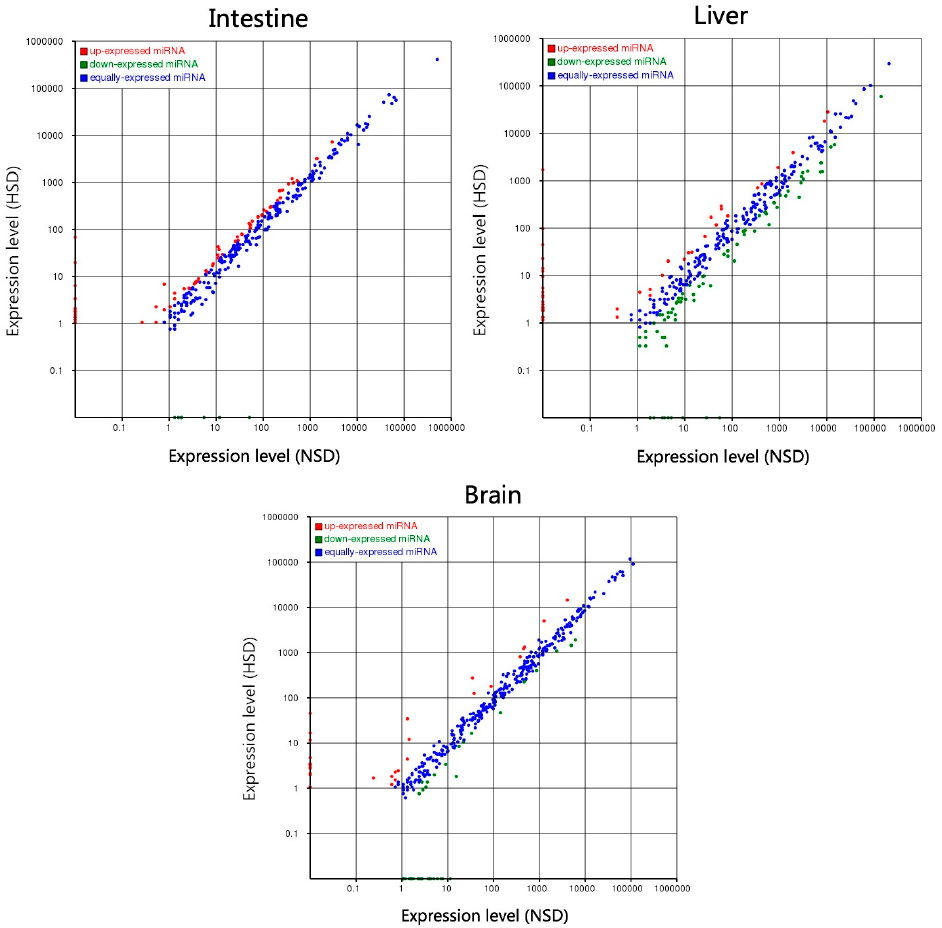
Figure 2. Differentially expressed miRNAs M. amblycephala. Red and green represents up- and downregulated miRNAs in high starch diet (HSD) group, compared with low starch diet (NSD) group. |log2FC(Fold change)| ≥ 1 and p -value ≤ 0.05.